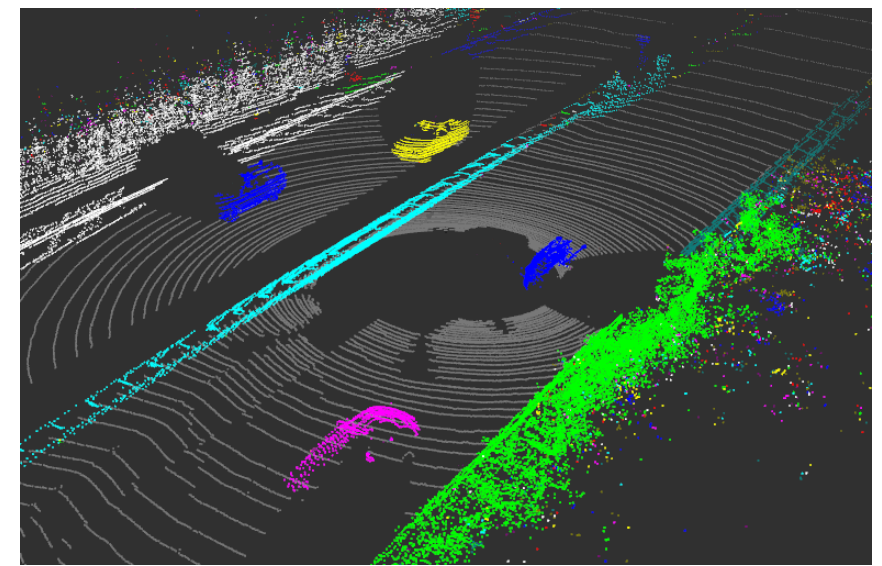
Figure 1. The points with different colors represent different traffic